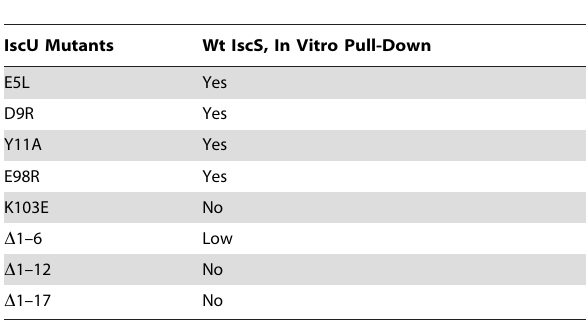
Table 2. Interaction between wild-type IscS and IscU mutants measured in vitro by pull-down (yes, binding observed; no, no binding).